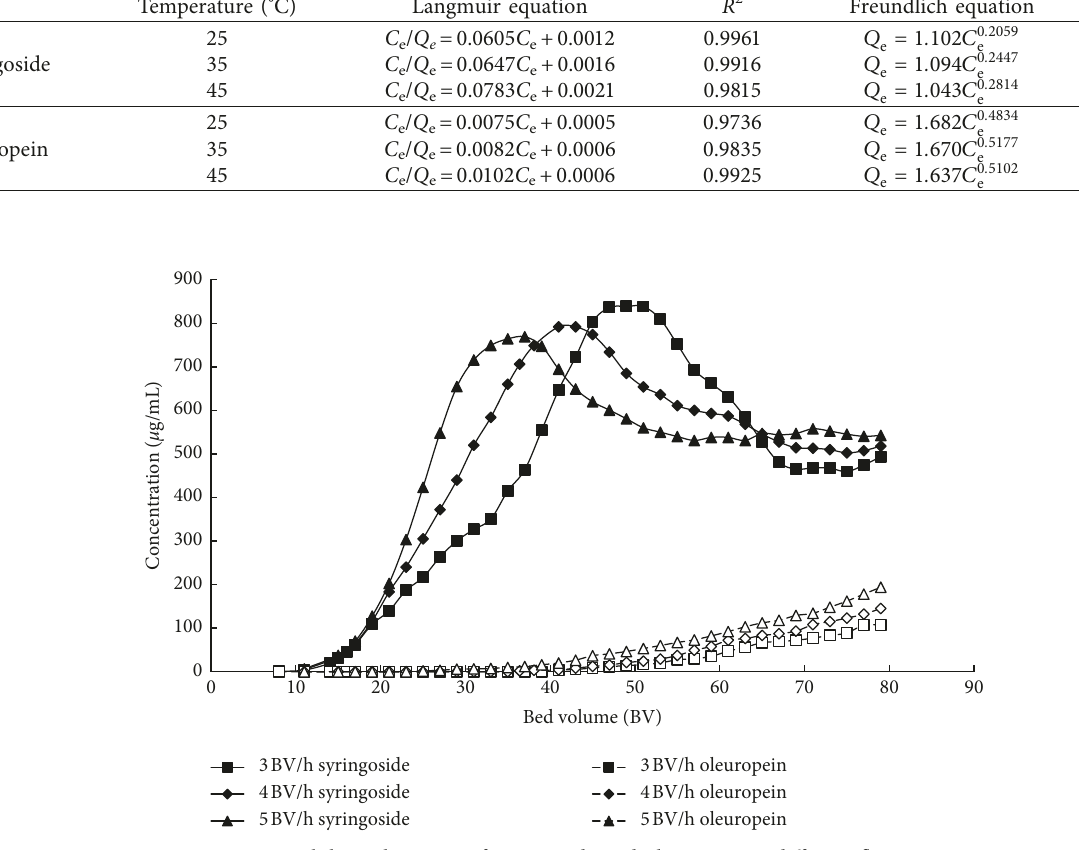
Figure 6: Breakthrough curves of syringoside and oleuropein at different flow